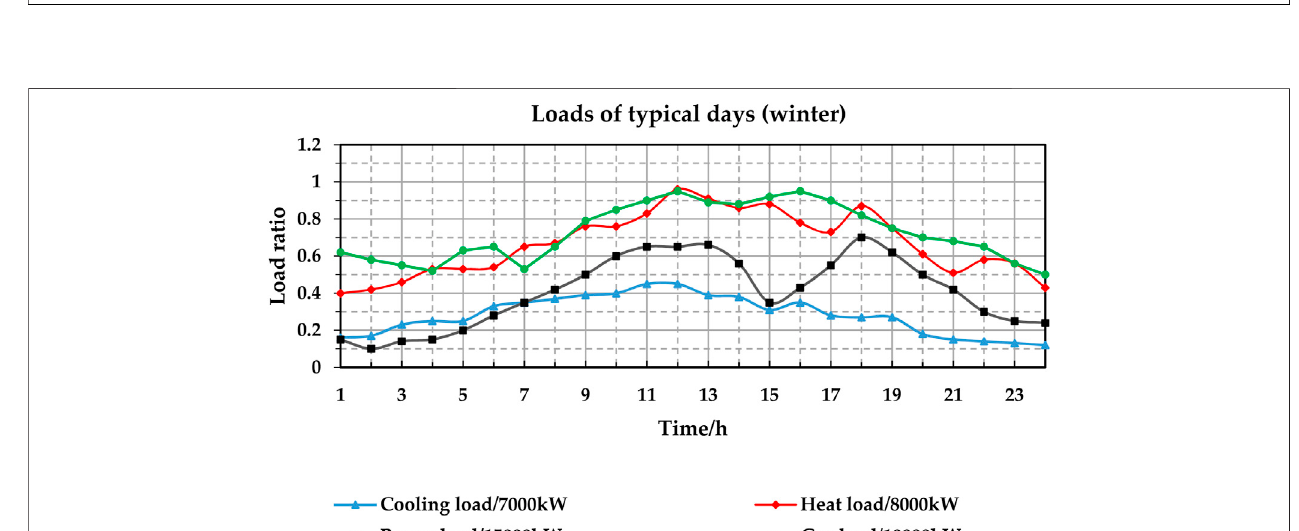
FIGURE 7 | Representative daily load curve in winter.